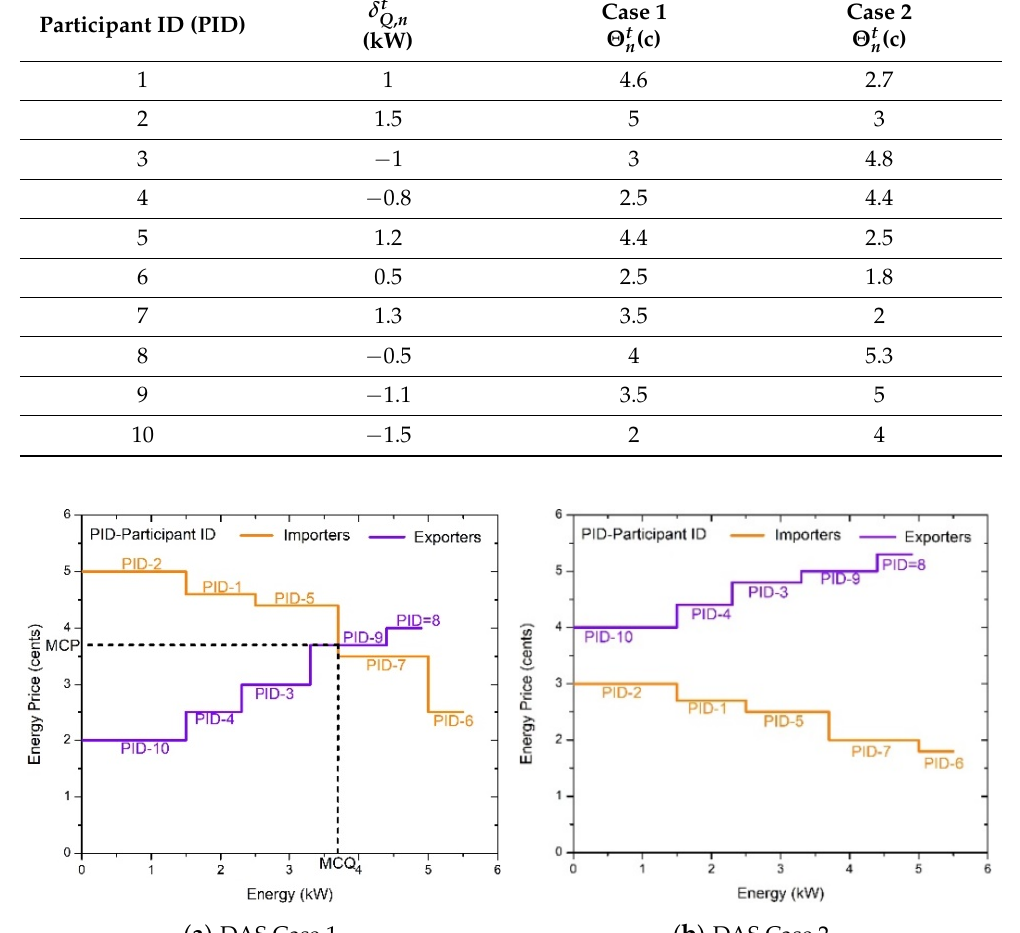
Figure 10. P2P energy market-clearing with DAS technique. Table 1. Participants’ quoted demand and price for P2P energy market.